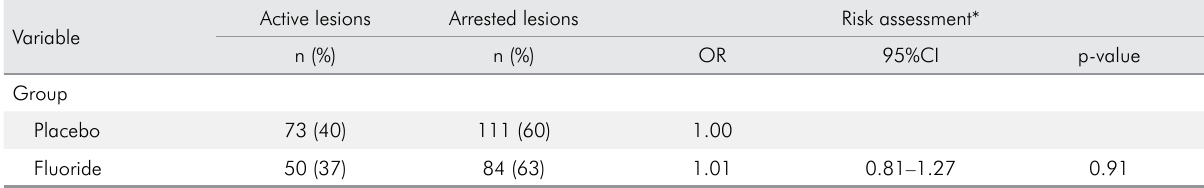
Table 3. Association between group and lesion arrestment. n = 318 lesions.